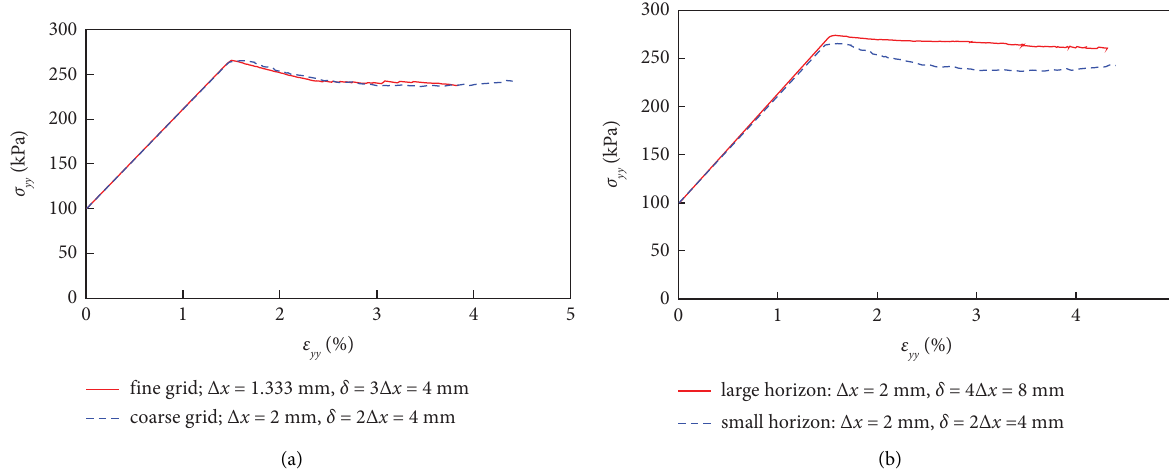
Figure 8: Stress-strain curves ( σ − ε yy yy ) of the point located in the shear band under diferent PD models: (a) diferent grid densities, but the horizon is kept fxed; (b) diferent horizons, but the grid spacing is kept